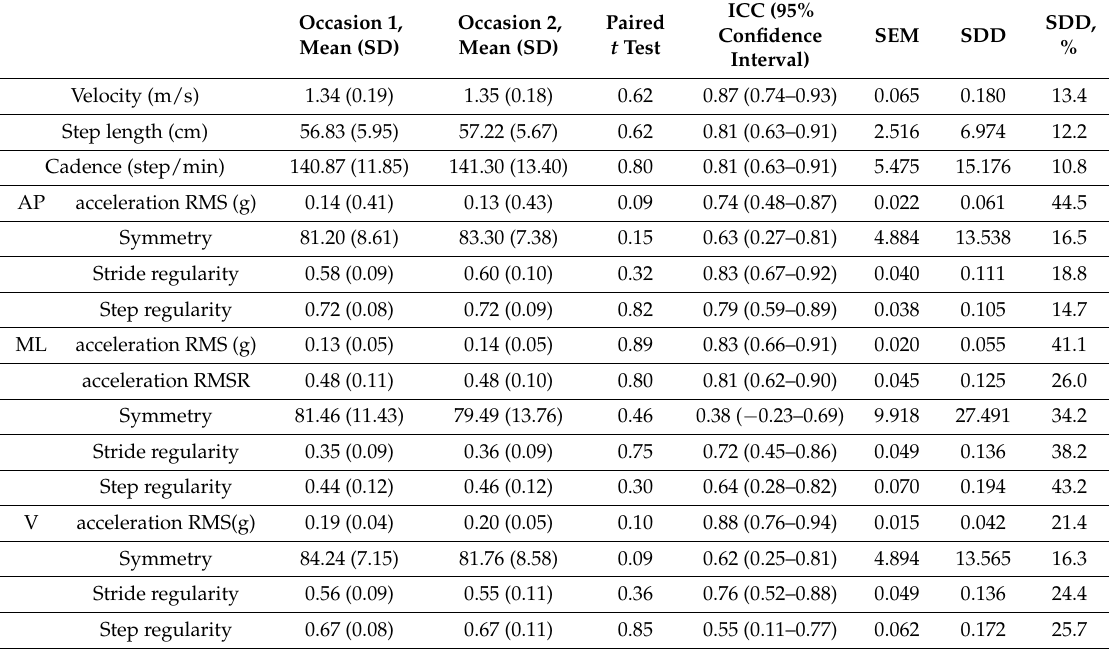
Table 2. Results for reliability assessment of IR-assisted accelerometer-based system in measuring gait parameters in healthy